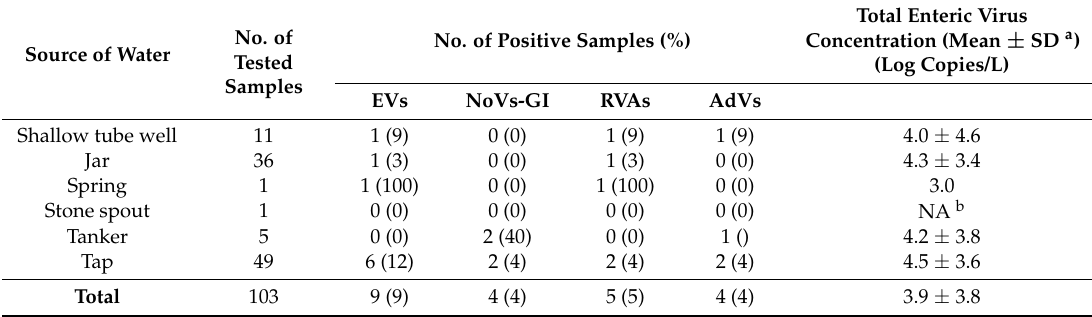
Table 2. Detection of enteric viruses in drinking water